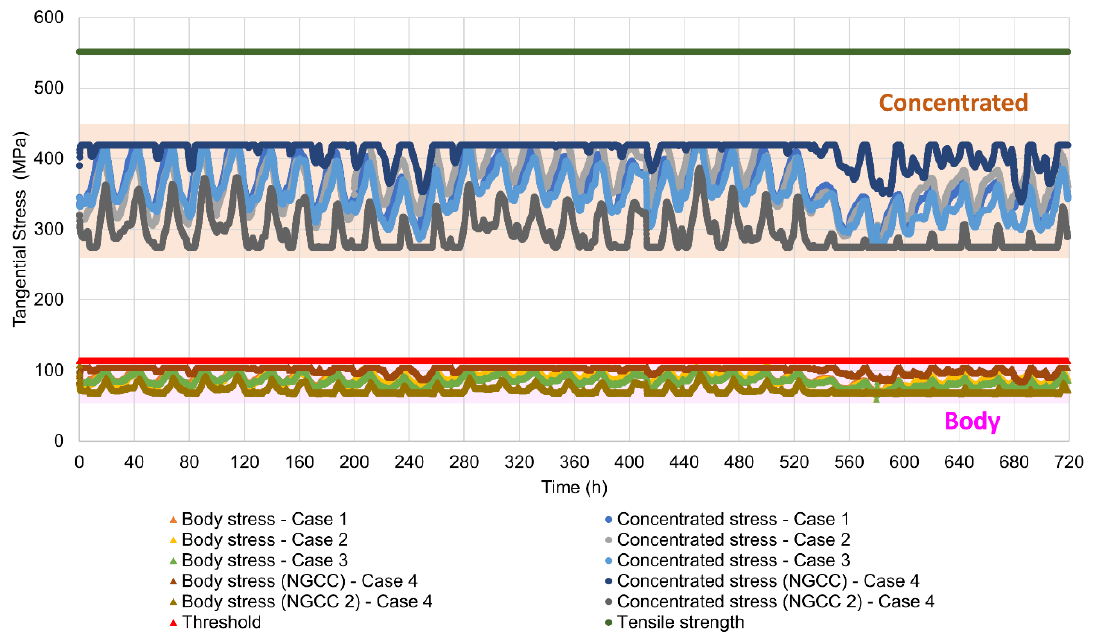
Figure 15. Drum body and concentrated tangential stresses during dispatch: Cases 1 to 4.